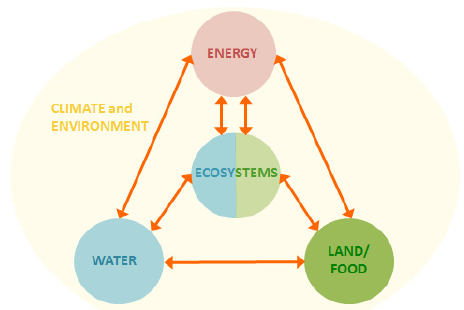
Figure A2. Intersectoral (nexus) graphs used to facilitate discussion at the workshop. Note: Initially—in the first workshop—“ecosystems” constituted a fourth corner in the nexus diagram (Figure A2). This caused confusion because “ecosystems” often logically overlaps with land and water resources (for example, when discussing an impact on water quality participants were unsure if to consider water or ecosystems). The diagram was reviewed accordingly, and “ecosystems” was colored half in blue and half in green to show this overlap [23].